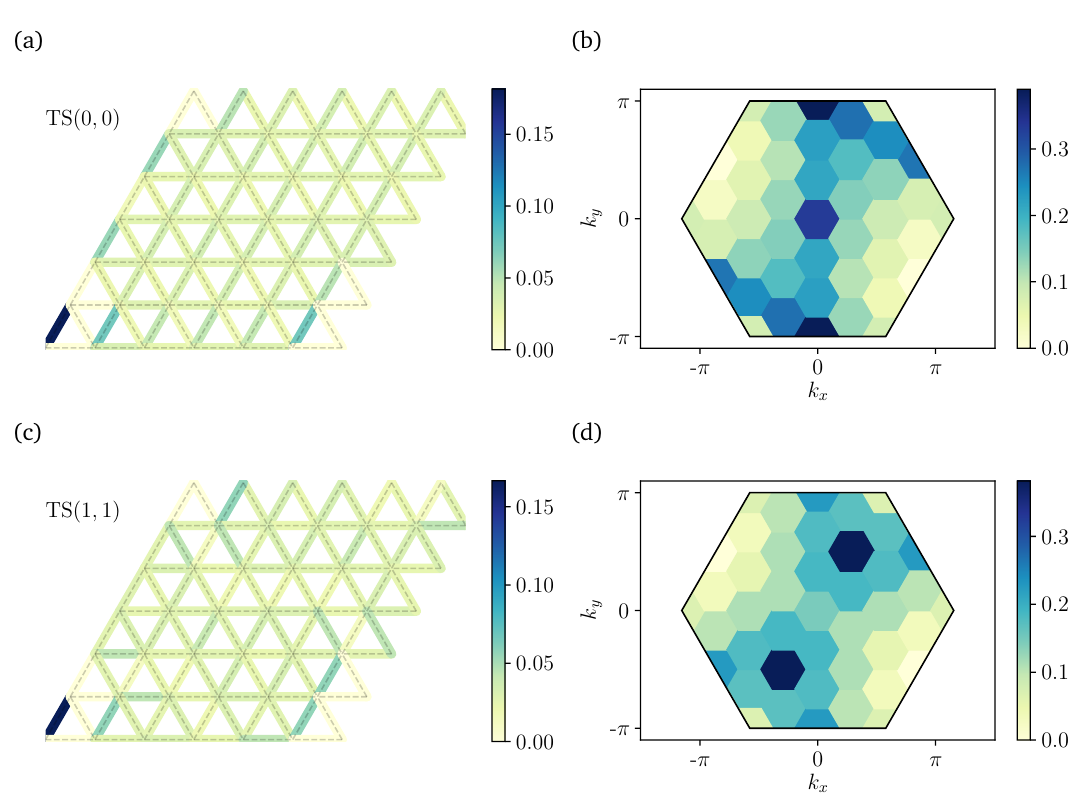
〉 (where b = 1 if the i th bond is b i i 1 = 0 otherwise) in the lowest energy state in the i 〉 − 〈 b 〉〈 b 〉 b i i 1 1